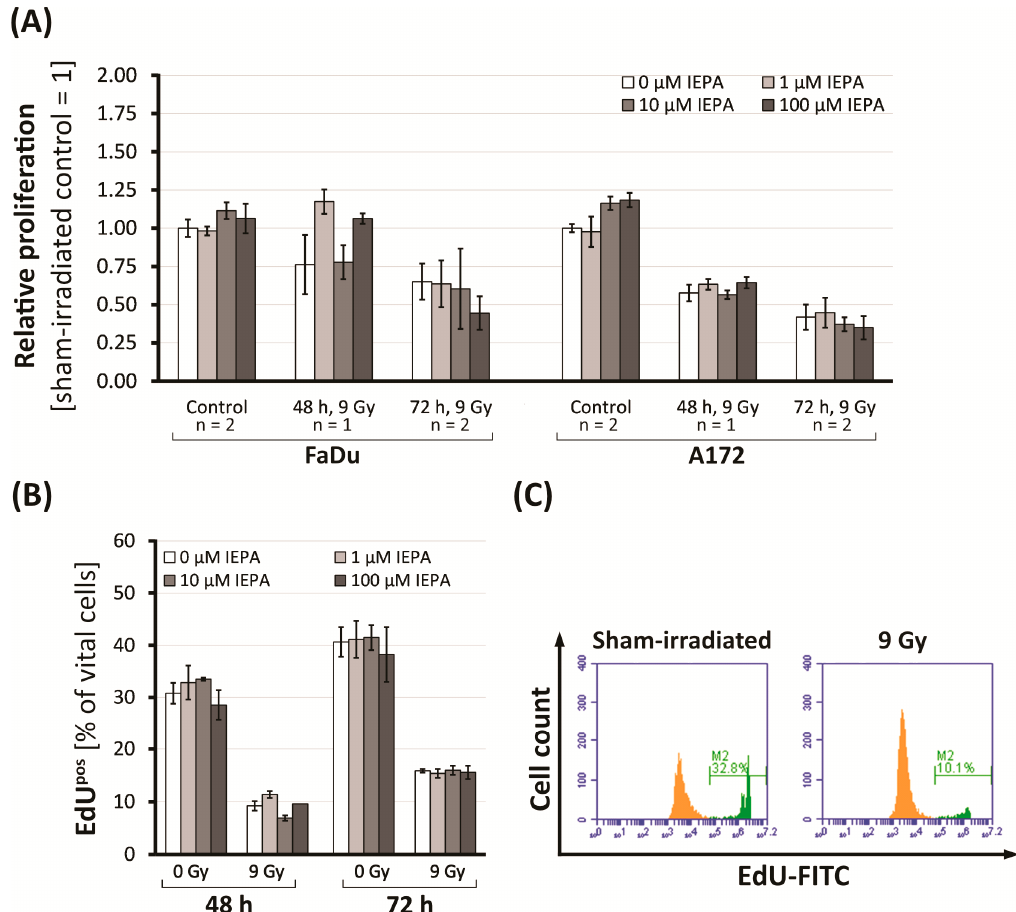
Figure 2. ( A ) Proliferation (BrdU assay) in FaDu and A172 cells 48 and 72 h after IR and treatment with IEPA related to control. For control and 72 h, mean values of two experiments ± SEM are presented. For 48 h, mean values of single experiments ± SEM conducted in triplets (FaDu) or quadruplets (A172) are shown. ( B ) Proliferation (% of EdU pos cells) in CD34 + HSPCs after IR and treatment with IEPA. Data represent a single experiment in duplicates; mean ± SEM. ( C ) Flow-cytometric histogram of CD34 + HSPCs 48 h post-IR with fraction of EdU pos cells highlighted in green.